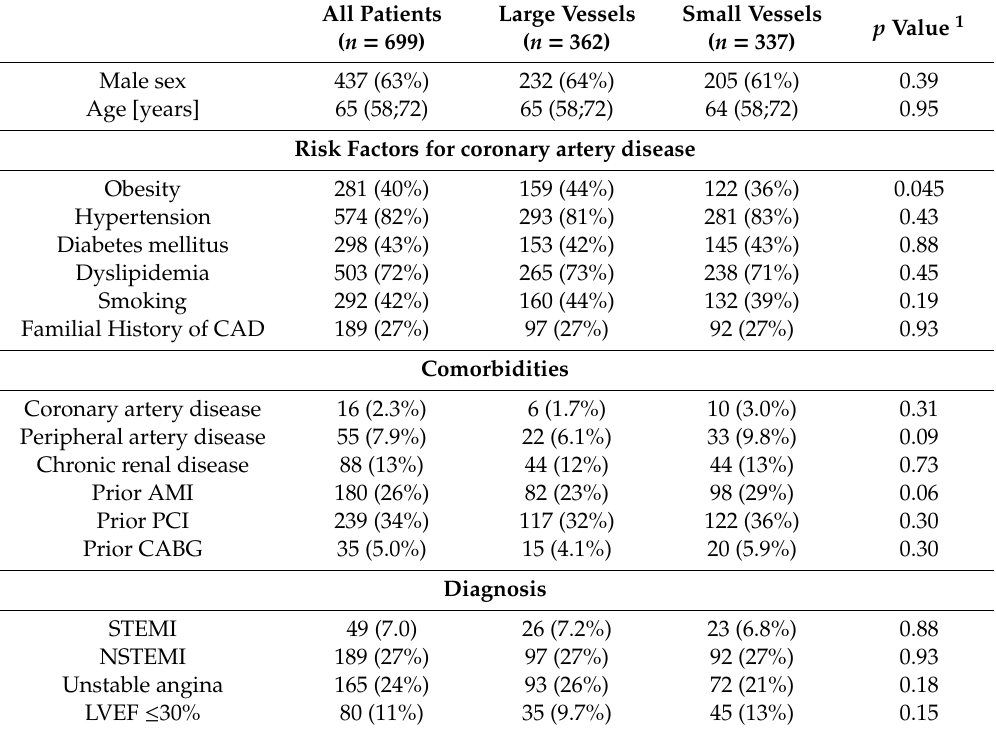
Table 1. Clinical characteristics.